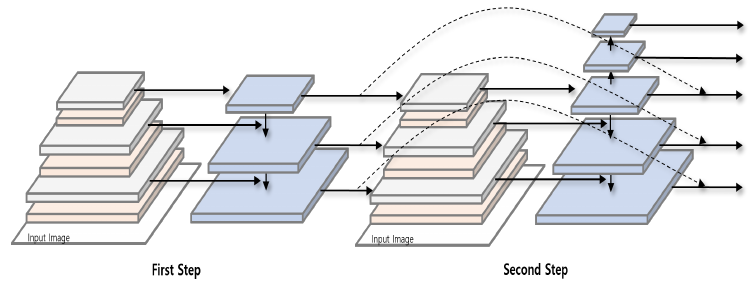
Figure 6. Recursive multiscale feature extraction